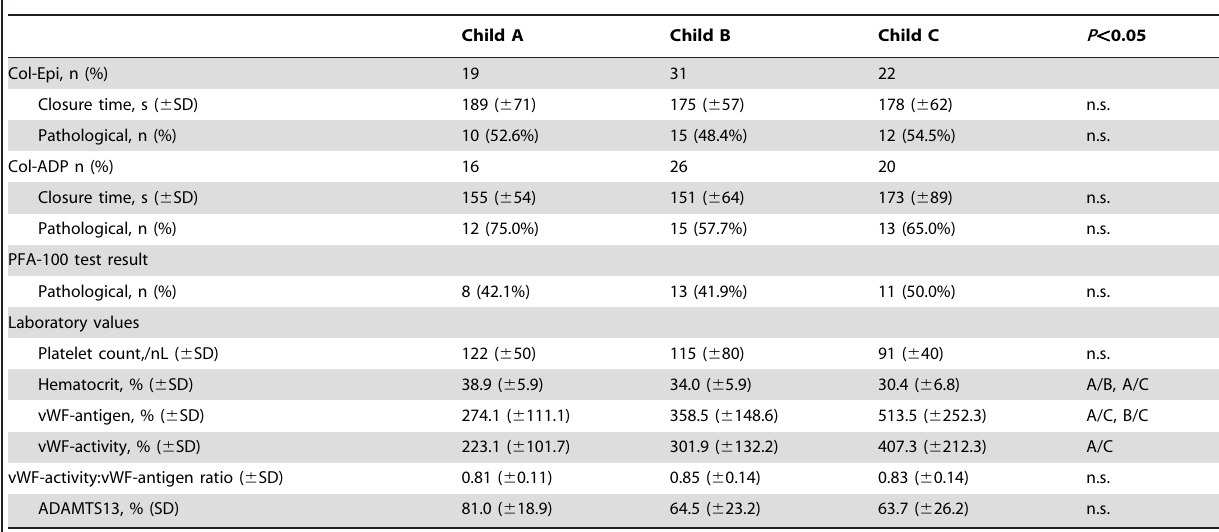
Table 2. Results for PFA-100, full blood count, and